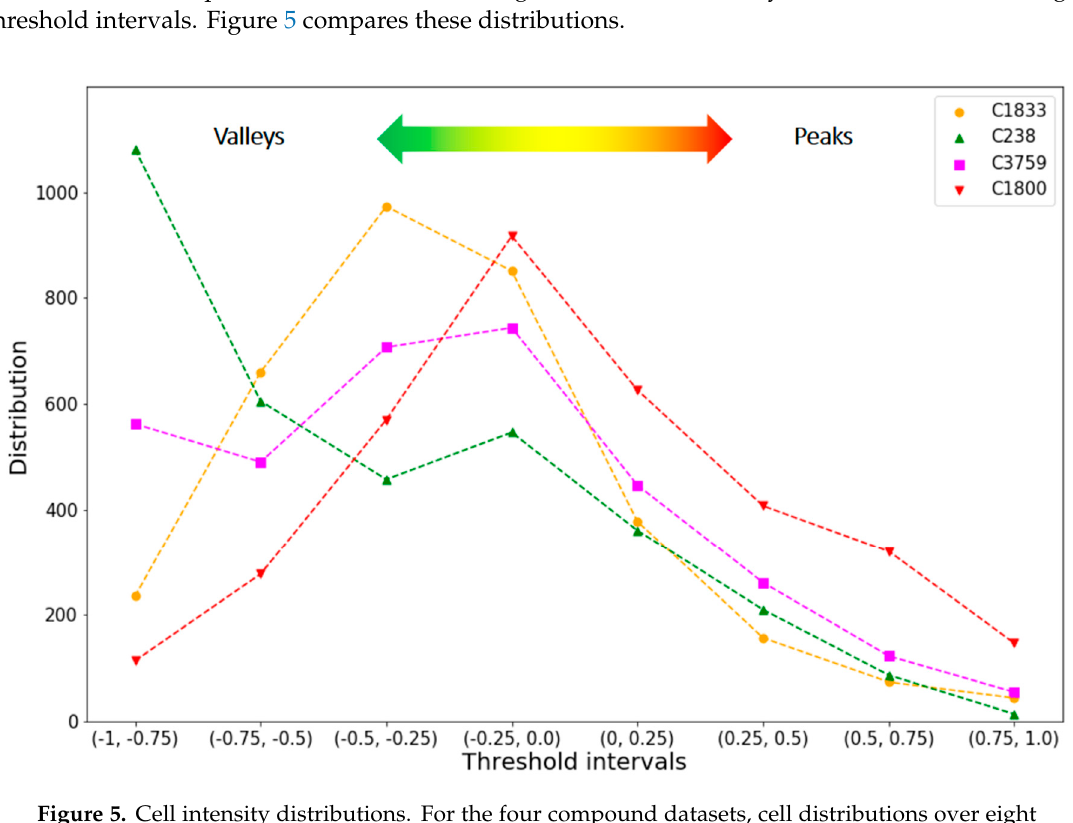
Figure 5. Cell intensity distributions. For the four compound datasets, cell distributions over eight threshold intervals are reported and color-coded as indicated. From left to right, valleys (interval 1–3), intermediate regions (interval 4,5), and peaks (interval 6–8) are accounted for.